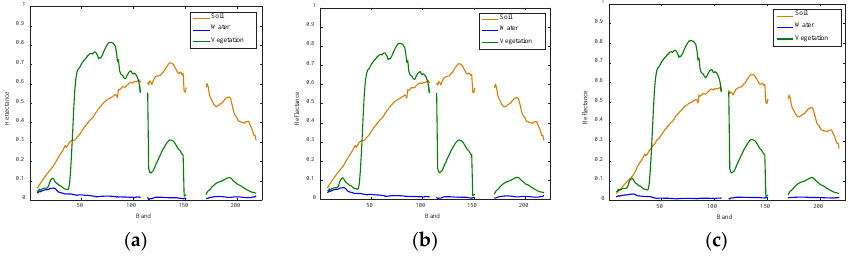
Figure 14. Endmembers extracted by BCNMF based on three BMMs: ( a ) FM; ( b ) GBM; ( c ) PPNM.